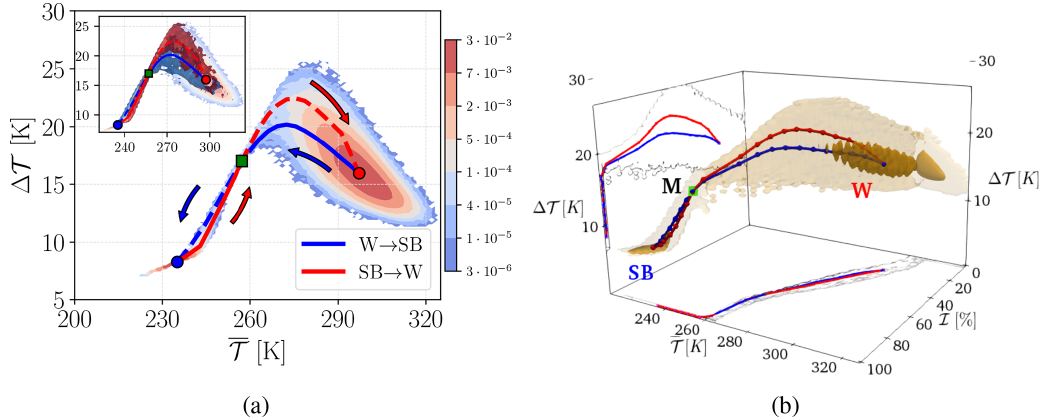
Figure 4. (a) Invariant measure in the 2D-projected state space defined by (cid:0) T ,(cid:49) T (cid:1) . The coloured points indicate the deterministic attractors of the SB (blue), M (green), and W (red) states, and the blue (red) line is the stochastically averaged transition paths for the W → SB (SB → W) transitions. Dashed (solid) lines are the relaxation (instantonic) trajectories. The arrows show the direction of transitions. The top left inset shows that the dark blue (red) contours portray the ensembles of the transition paths between W → SB (SB → W). Here, the system is driven by Gaussian noise with ε = 0 . 14. (b) The invariant measure and most probable transition paths (W → SB in blue and SB → W in red) in the 3D-projected state space are defined by (cid:0) T ,(cid:49) T , I (cid:1) . The darker brown shading indicates a higher probability density for the corresponding isosurface. The 2D projections on the (cid:0) T , I (cid:1) , and ((cid:49) T , I ) planes are shown. The location of the M state is given by a pink square. Here, the system is driven by Gaussian noise, with ε = 0 .